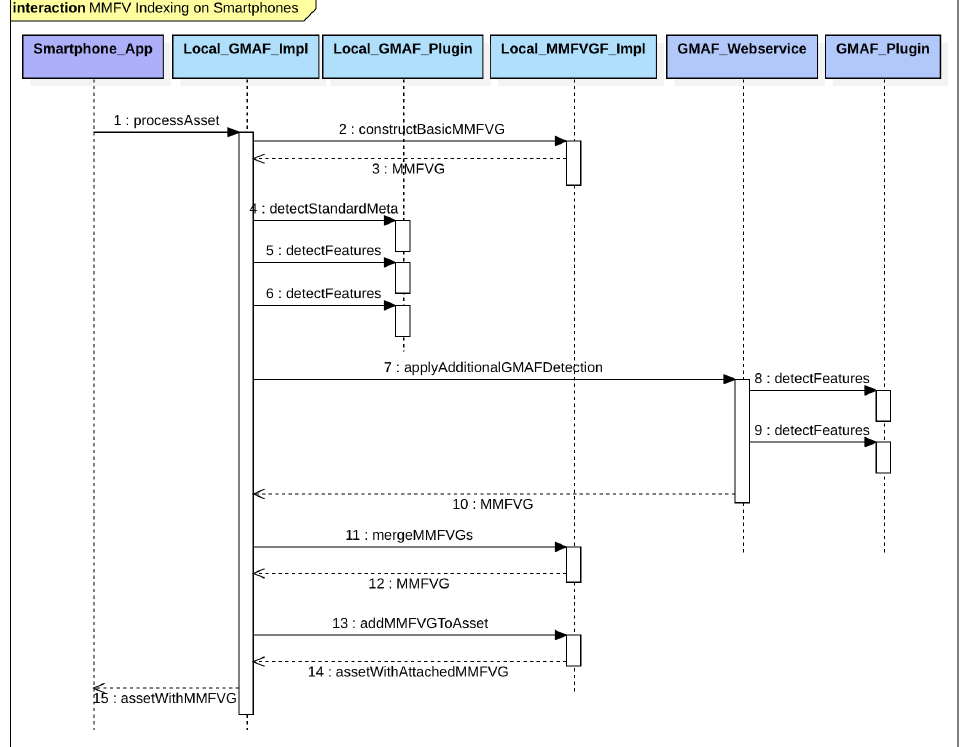
Figure 10. Sequence diagram of typical processing flow within the